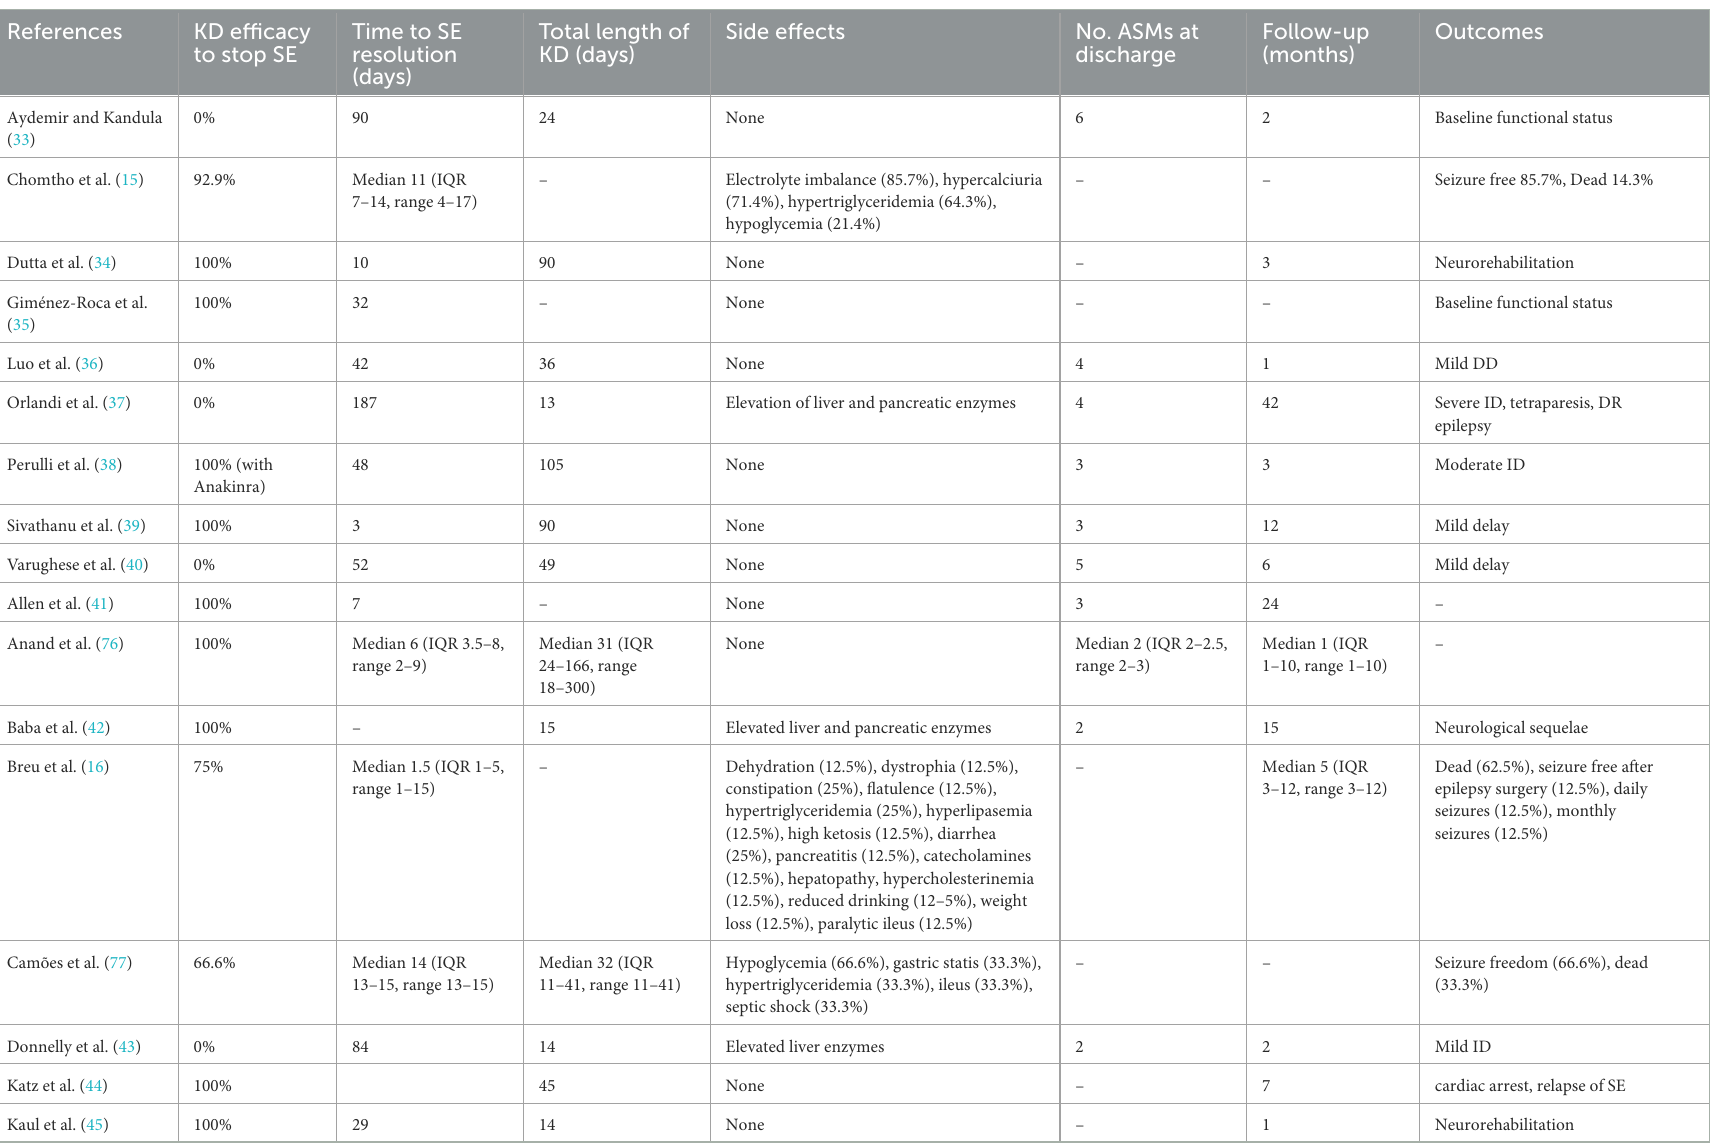
TABLE 4 Systematic review: response to KD and